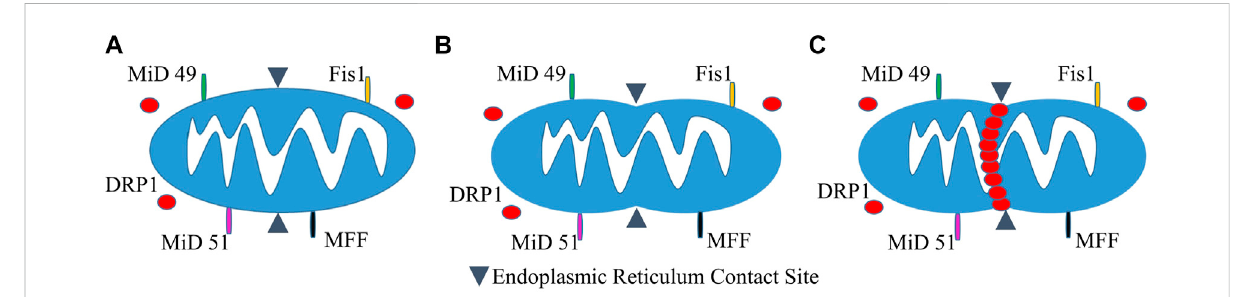
FIGURE 1 Mitochondrial Fission. (A) Fis1 and potential DRP1 recruitment candidates MiD 49, MiD 51, and MFF reside on the OMM with most of the protein facing the cytosol. DRP1 exists in both the cytosol and in punctate spots on mitochondria (not shown). (B) An initial constriction of mitochondrial tubules occurs at sites of endoplasmic reticulum contact independent of DRP1 . (C) Mitochondrial fi ssion proceeds as DRP1 is recruited to the OMM and further constricts the mitochondrial